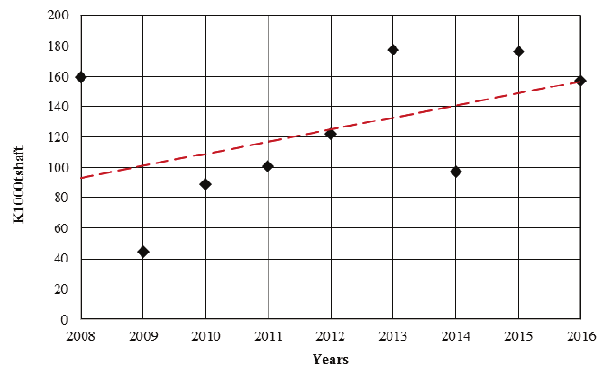
Fig. 19. Changes of the coefficient K 1000tshaft and the trend line